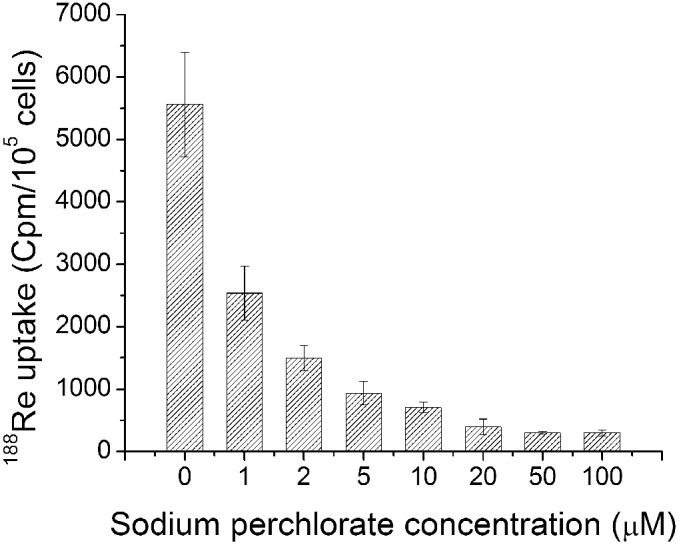
Sodium perchlorate inhibition study.Sodium perchlorate was added at the indicated concentration (0, 1, 2, 5, 10, 20, 50, and 100 µM) and 188Re uptake was measured. Results are expressed in numbers of counts per minute for 105 cells. Bars are means ± SD (n = 3).